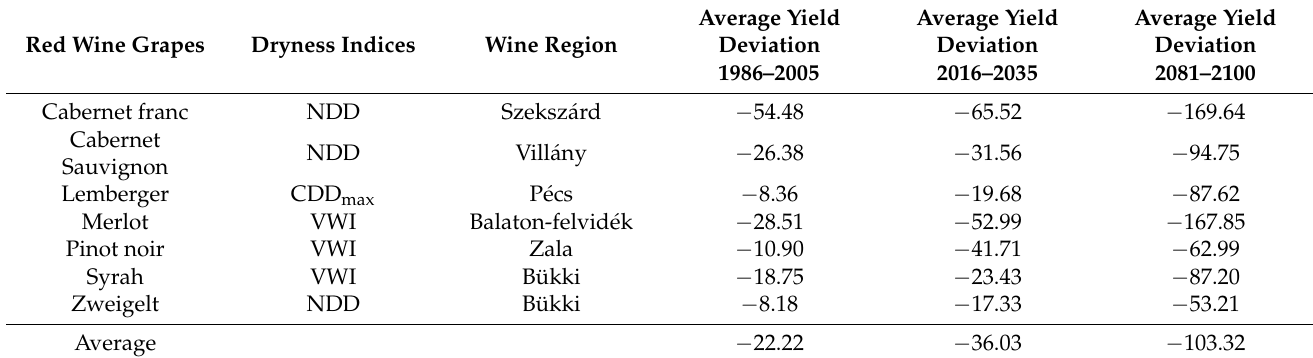
Table 11. Average estimated deviations of red wine grape yield (q/ha) from the agricultural trends produced based on the regression coefficients of the best quadratic fits of dryness indices in the different 20-year periods. The deviations for which the t-test indicated significant differences are set in italics (five such pairs are found, each one for the distant future).